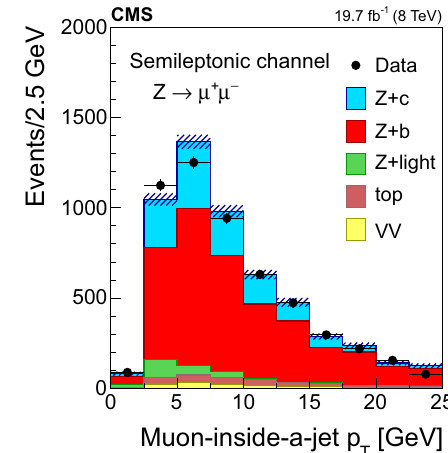
Fig. 1 Transversemomentumdistributionoftheselected muon-inside- a-jet foreventswithanidentifiedmuonamongthejetconstituents,inthe dielectron (left) and dimuon (right) channels. The contributions from